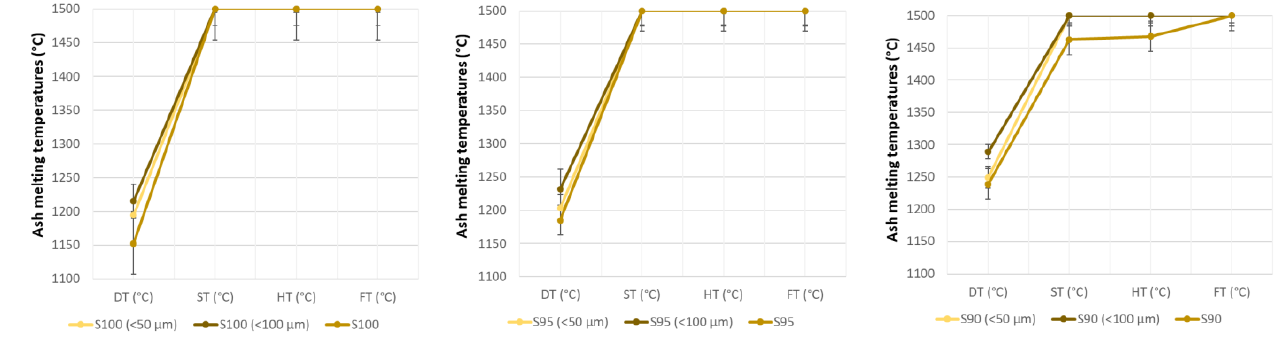
Figure 6. Differences in melting temperatures for spruce samples prepared at 815 °C.